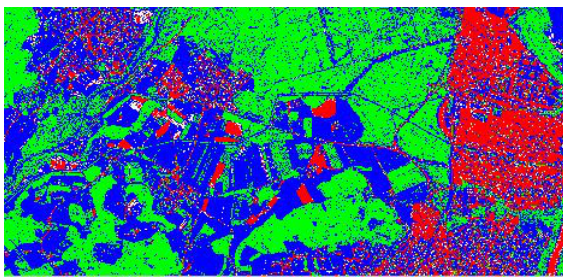
Figure 5. The histogram segmented image by the proposed system 3.3 Black and white image conversion: This process converts the histogram segmented image to a binary image. The image has its pixels replaced by either a black or white colour depending on whether the pixel is in a classified category in a region of interest. The input image pixels are replaced with the value ‘1’ (white) if the input pixels are in ROI areas, i.e. forest, urban and agriculture, whereas other pixels are replaced with the value ‘0’ (black) if they are categorised as the not interested area. Figure 6 shows the conversion of the histogram segmented image, to a black and white image. In this example using the manual histogram classification, there are some pixels, which are not classified to any group and produced some error in the